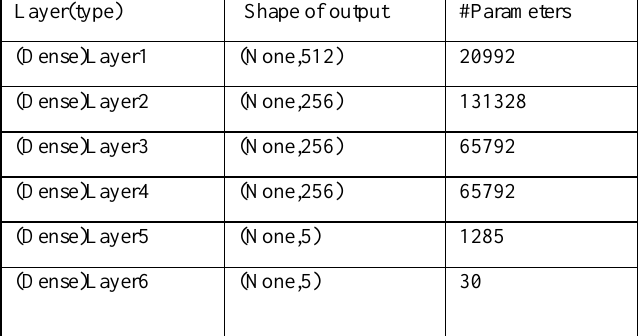
Table 1. Parameters values in I nput- Output